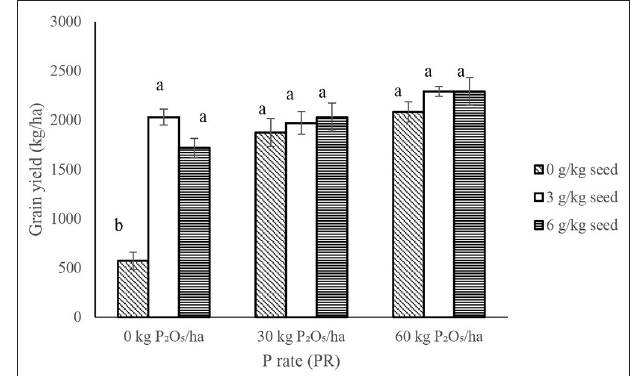
FIGURE 3 | Interactive effect of P-rate (PR), inoculant rate (IR), and variety (V) on pod number of groundnut grown in Haplic Lixisols of northern Ghana. Bars with different letters (in horizontal direction) show significantly different means. Error bars represent standard error of mean.